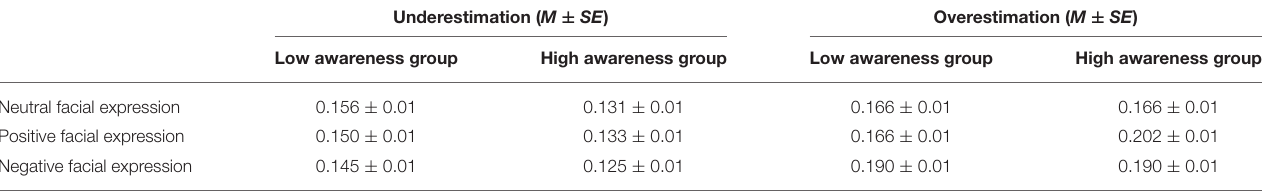
TABLE 1 | Means and standard error of overestimation and underestimation response ratio for the high and low awareness